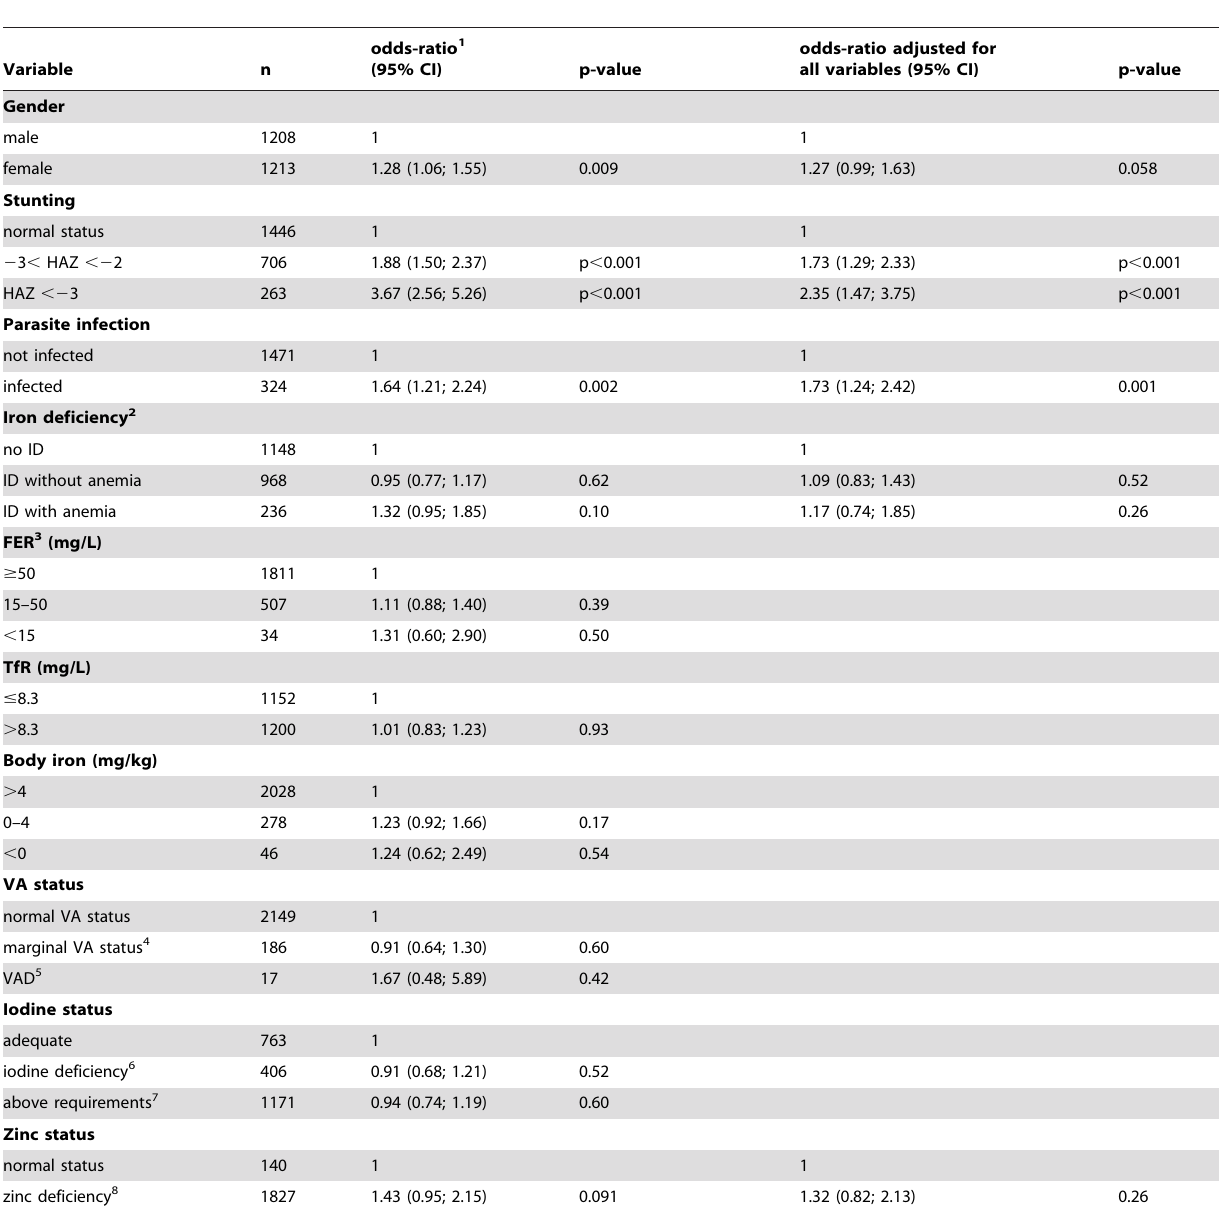
Table 4. Univariate and multivariate analysis of factors associated with poor performance in Block design test among participating